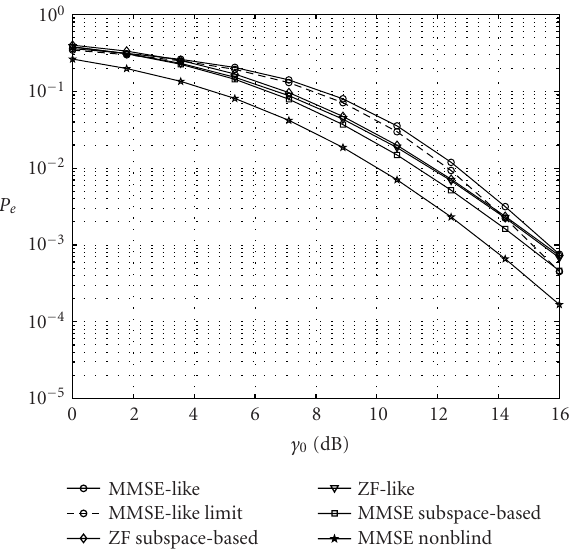
Figure 7: Channel estimation for a noncooperative reception scheme: K = 4, M = 8, N = 4, n t = 2, n r = 2, Q = 1300, and P = 1500.